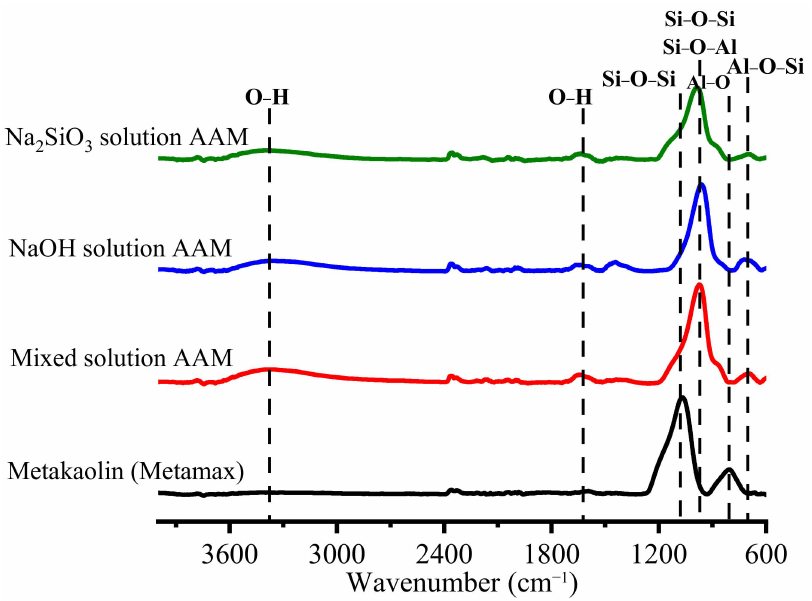
Figure 5. FTIR peaks of metakaolin and AAMs with different alkali activator